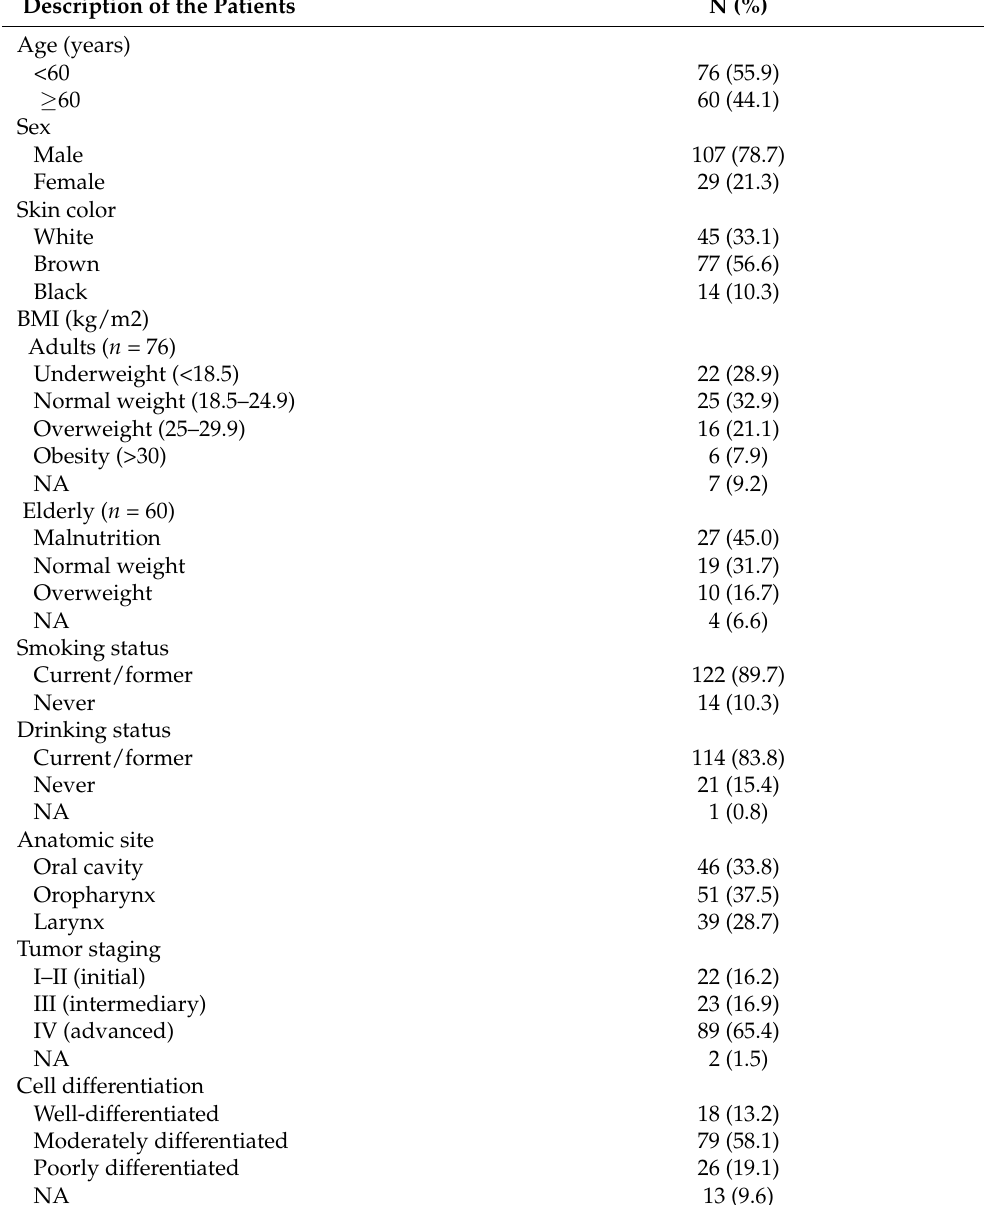
Table 1. Clinical and pathological data of patients with HNSCC ( n = 136). Description of the